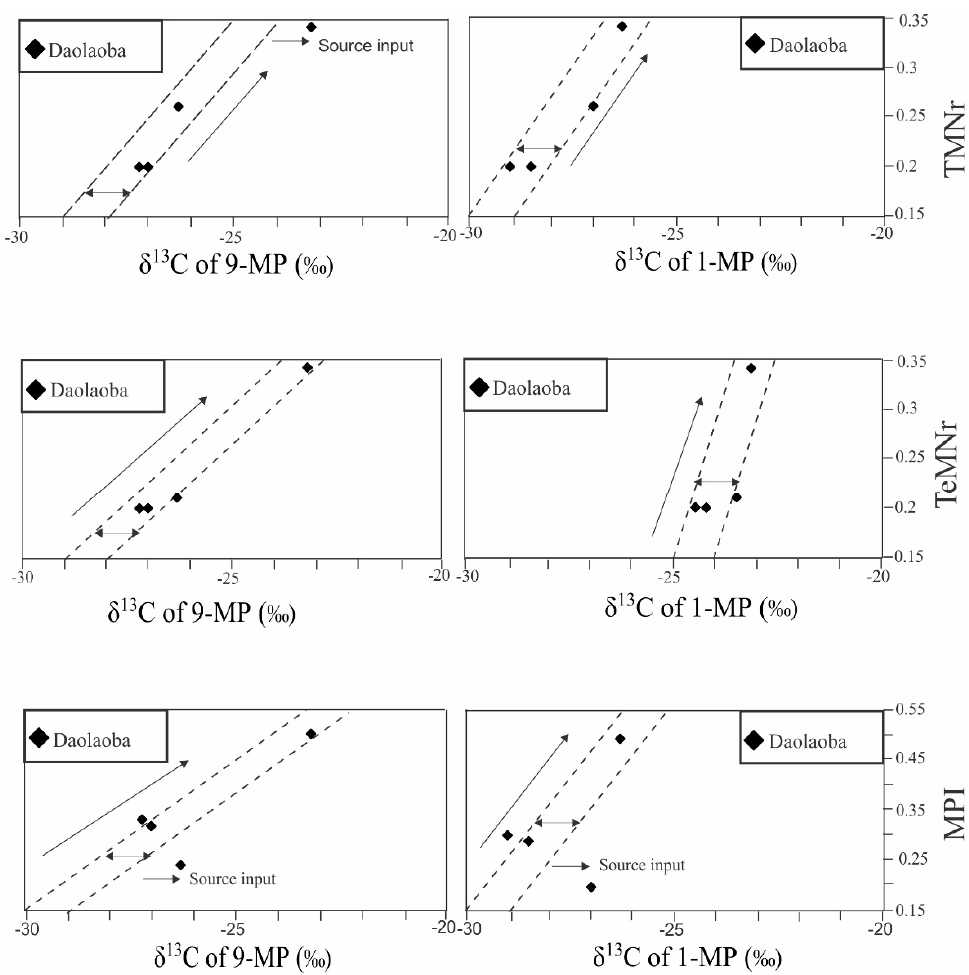
Figure 12. Cross plots of weighted mean δ 13 C values of individual aromatic isomers from the Daolaoba field versus maturity indicator parameters.